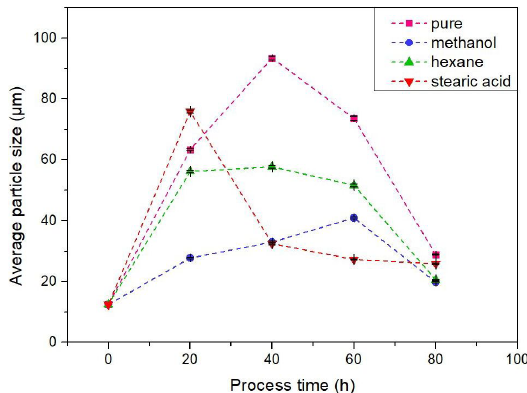
Figure 4. Average Fe-15at.%Nb alloy particle size according to per PCA and milling